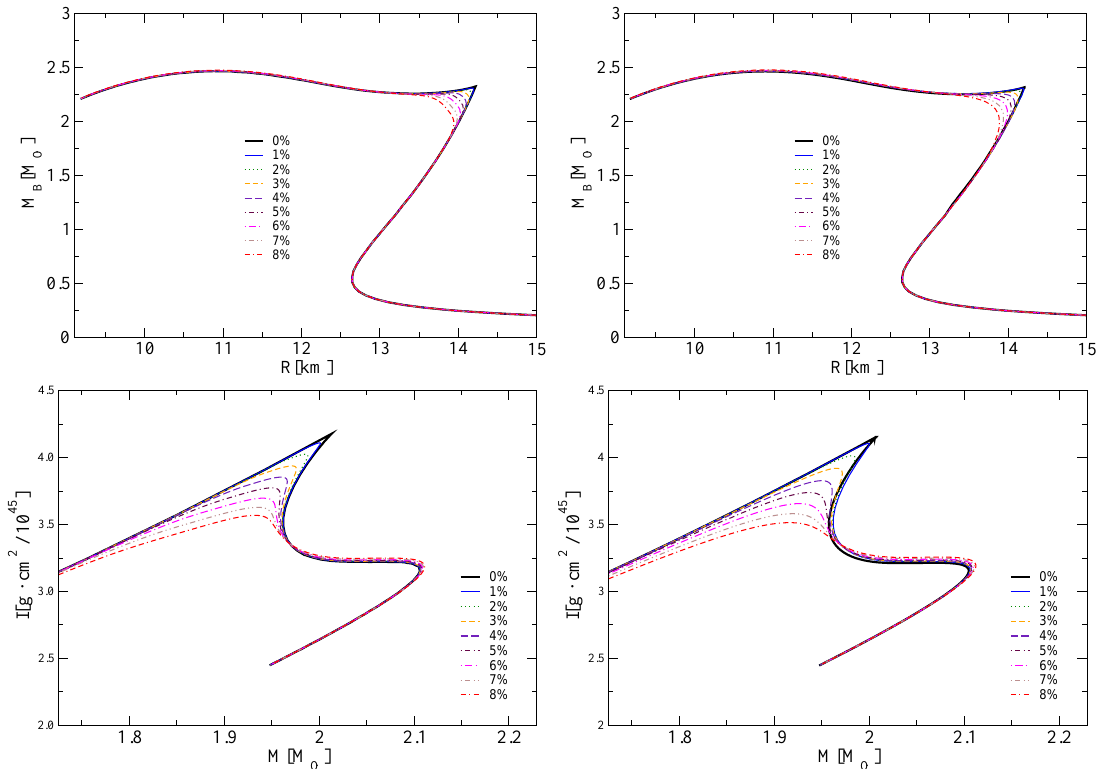
Figure 9. Upper panel : Baryonic Mass versus radius for both mixed phase approaches, MIM ( left panel ) and RIM ( right panel , k = 3). Lower panel : Moment of inertia as a function of total mass for MIM ( left panel ) and RIM ( right panel , k = 3) approaches. Each curve corresponds to an EoS with a chosen ∆ P value given as a percentage of the critical Maxwell pressure P c represented by alternating line-style values. The case ∆ P = 0 corresponds to the Maxwell construction which produces a sharp edge in the